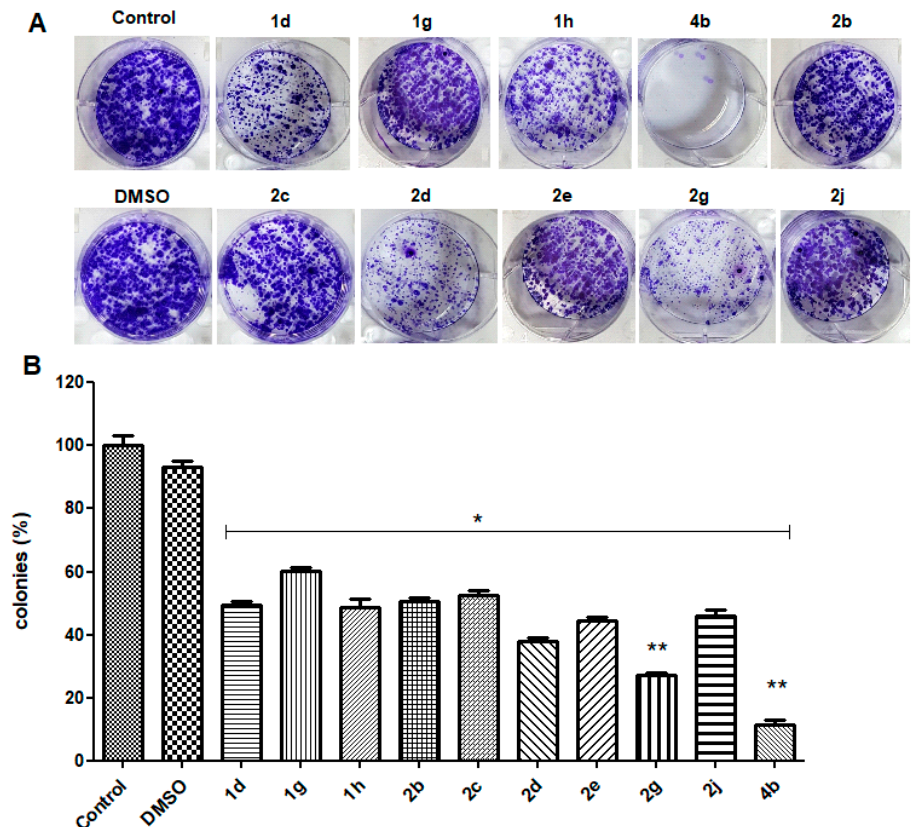
Figure 3. ( A ) Representative images of clonogenic assay in SH-SY5Y cells treated with the indicated drugs at 10 µ M. ( B ) Percentage of viable clones after drug treatments with respect to untreated cells. * p < 0.01 significant difference from control group, ** p < 0.01 significant difference from other com- pounds.